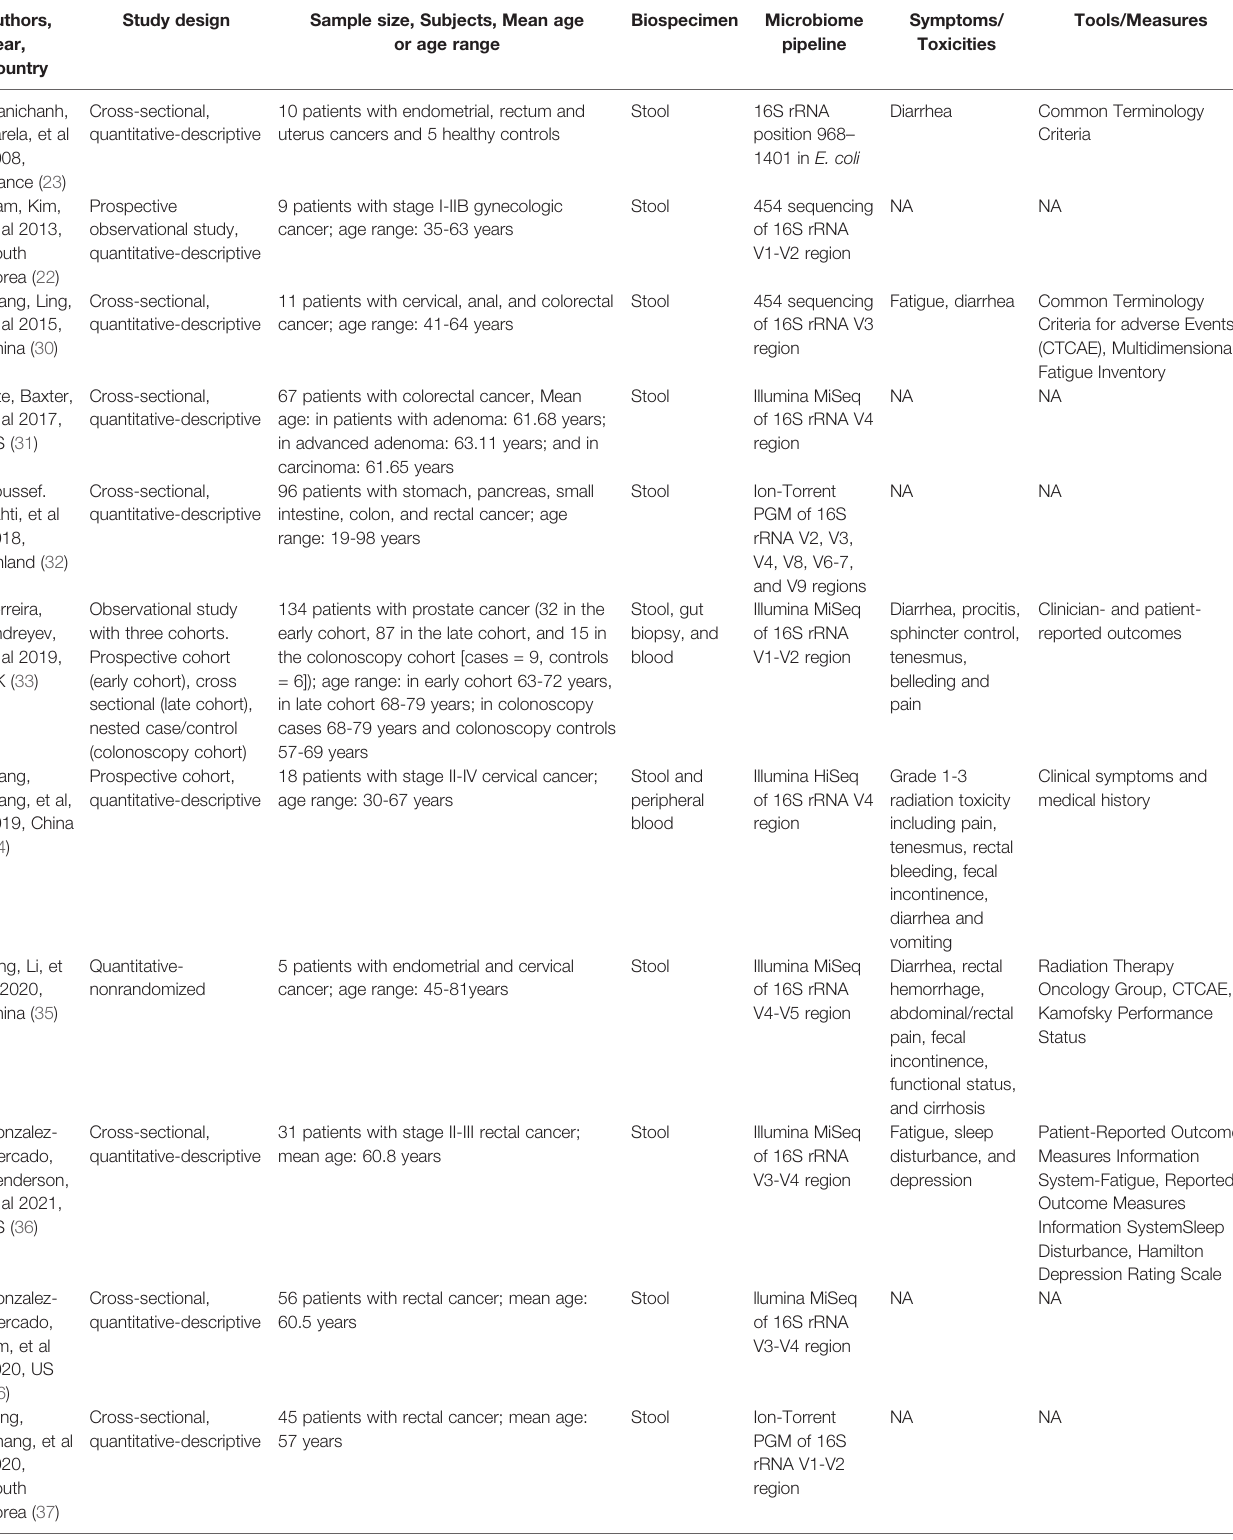
TABLE 1 | Characteristics of the Included Studies (n =